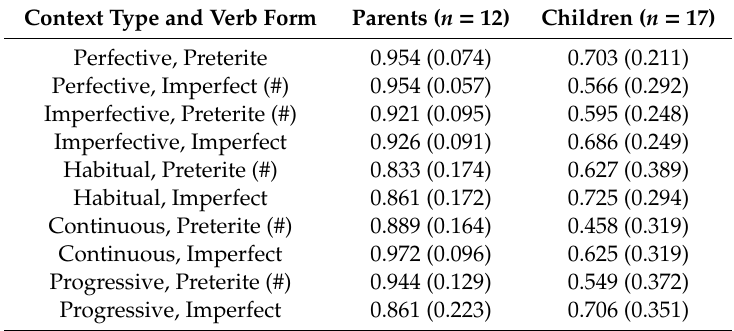
Table 3. Parents’ and children’s mean accuracy (%) and standard deviation with both morphemes in each of the four context